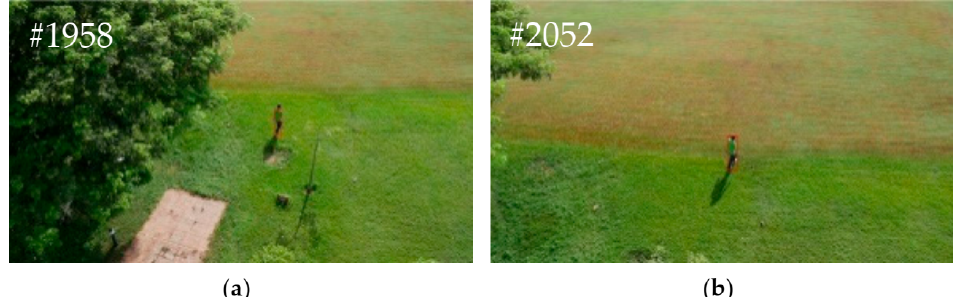
Figure 14. UAV123 datasets tracking test of person17. ( a ) Object waring similar color cloth with background and complex characteristics; ( b ) object against a background with similar characteristics.